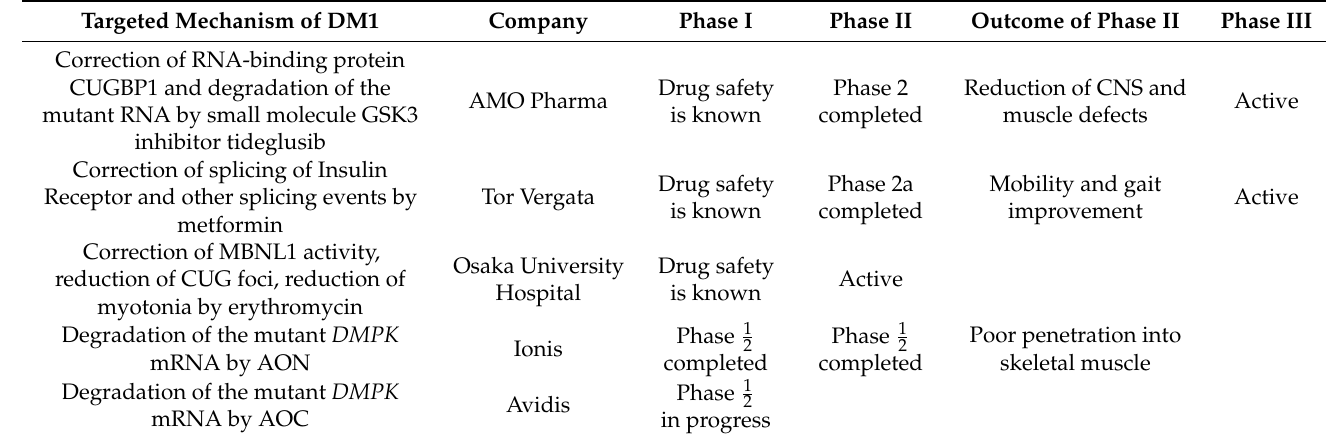
Table 1. Examples of clinical trials for DM1 which are based on correction of mechanisms, causing DM1 pathology (see text for details). AOC is antibody-oligonucleotide